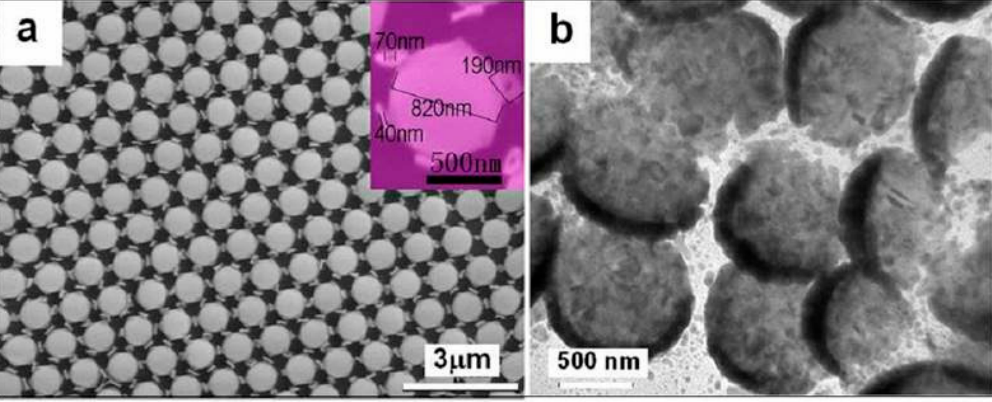
Figure 10. The morphology of the as-prepared Au binary-structured array from the colloidal template shown in Figure 5b. ( a ): The SEM image of the array. The inset is a local magnified image showing one single microsphere with six standing nanorings. ( b ): TEM image of the nanoshells in (a) (Guangqiang Liu et al. [29]).